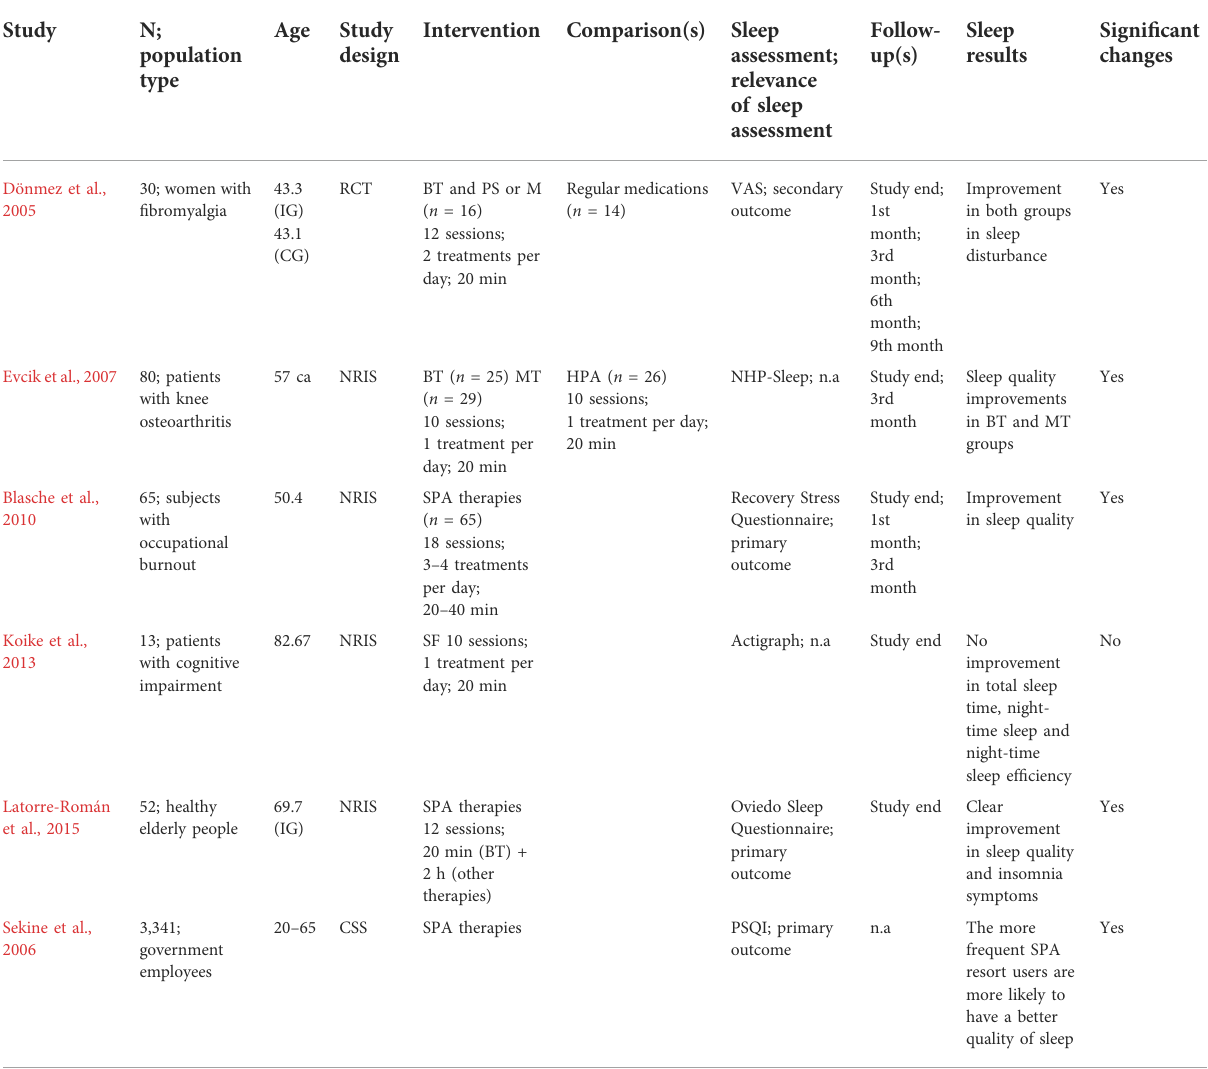
TABLE 2 Balneotherapy – Thermal water immersion with other spa treatments.